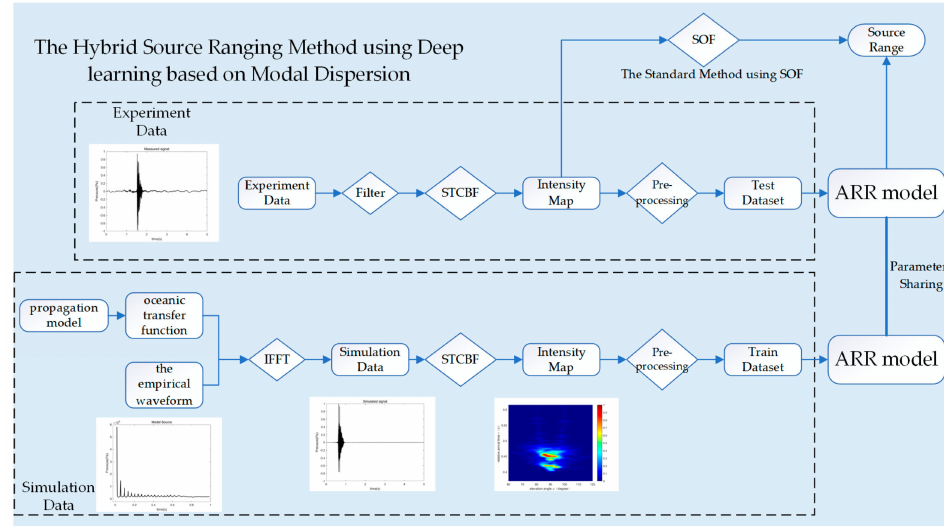
Figure 5. The scheme of the Hybrid–Source Ranging